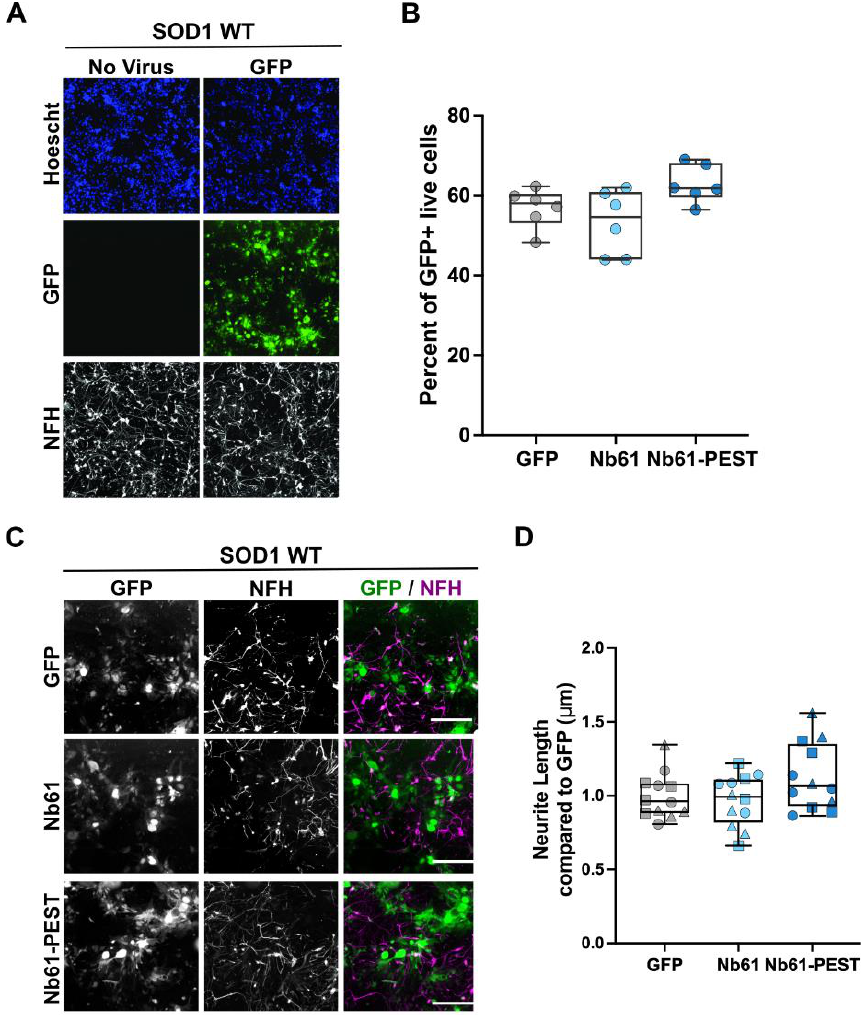
Figure 7. Nb61 constructs are nonlethal when expressed in human SOD1 WT motor neurons. SOD1 WT iPSC-derived human motor neurons were thawed, plated into 384-well dishes, and assessed as described for the SOD1 A4V neurons in Figure 6. ( A ) Immunofluorescence images of SOD1 WT neurons, either non-transduced ( left ) or transduced ( right ) with a control lentivirus expressing GFP. Motor neurons were identified with anti-NFH staining. Scale bar = 200 µ m. ( B ) Quantification of the transduction efficiency for the indicated lentivirus from a representative biological replicate. ( C ) Immunofluorescence images of SOD1 WT iPSC-derived motor-neuron cultures at DIV7 that were transduced with a control GFP-expressing lentivirus or lentivirus co-expressing Nb61 or Nb61-PEST and GFP. NFH staining was used to identify motor neurons. Scale bar = 200 µ m. ( D ) Quantification of total neurite length of SOD1 WT ( n = 2) iPSC-derived motor neurons that were transduced with a control lentivirus expressing GFP or lentivirus co-expressing Nb61 or Nb61-PEST and GFP. Neither Nb61 nor Nb61-PEST altered neurite length compared to SOD1 WT neurons transduced with control GFP lentivirus. Data represent three experimental replicates, each denoted by a different symbol. Kruskal–Wallis with Dunn’s multiple comparison test was used for analysis; no significant comparisons were